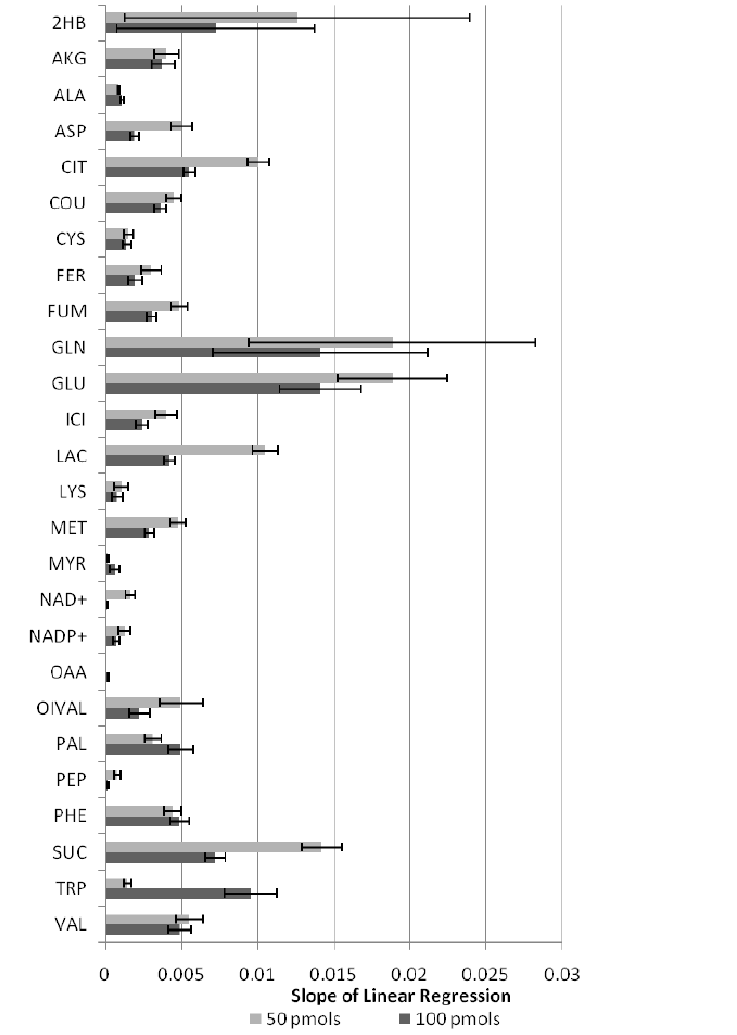
Figure 4. Slope values obtained from the linear regression of the GC peak areas of silylated (TMS) metabolite derivatives analyzed four times during 72 hours. Legend shows concentration of metabolites per samples. See Table 1 for metabolite